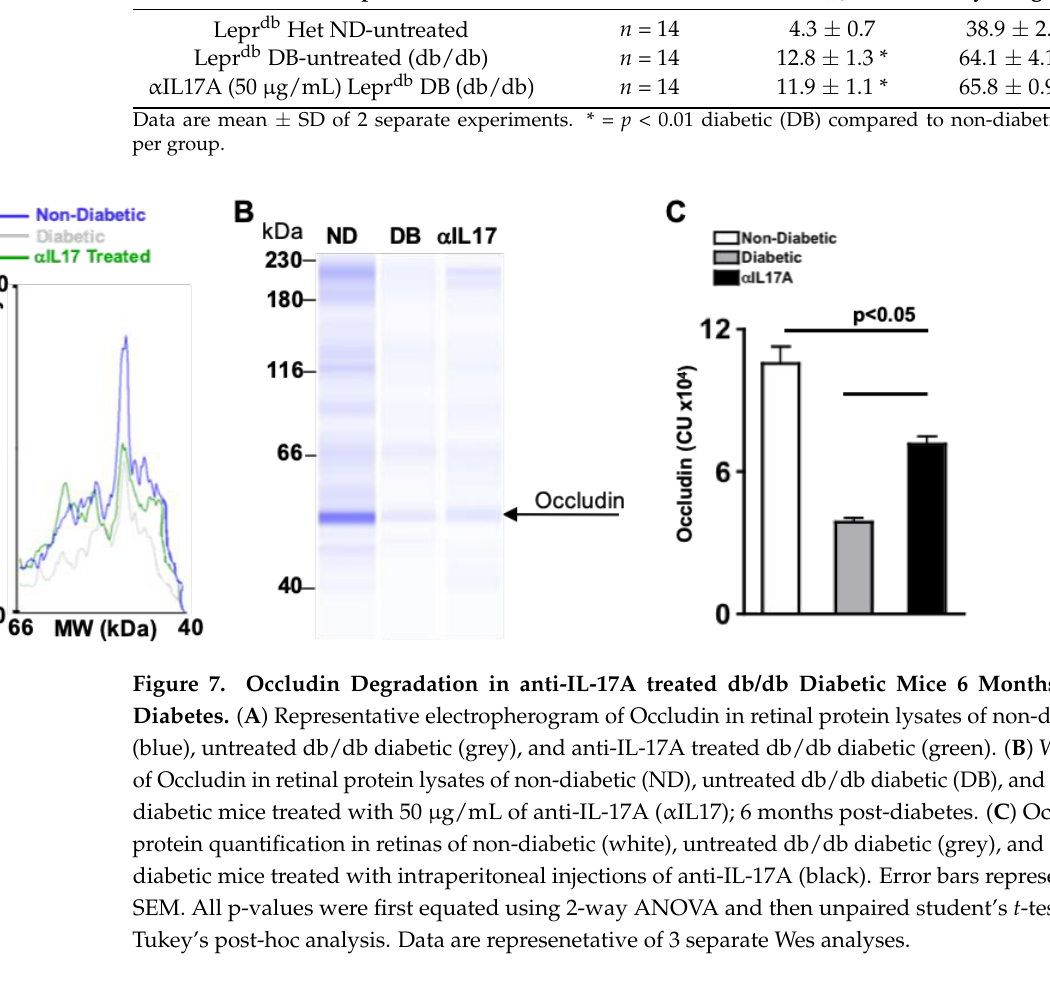
Table 5. Clinical data of db/db mice receiving weekly intraperitoneal injection of 50 µ g/mL of anti-IL-17Al 6 months post-diabetes. Group Number of Mice HbA 1C (%) Body Weight (g) Lepr db Het ND-untreated